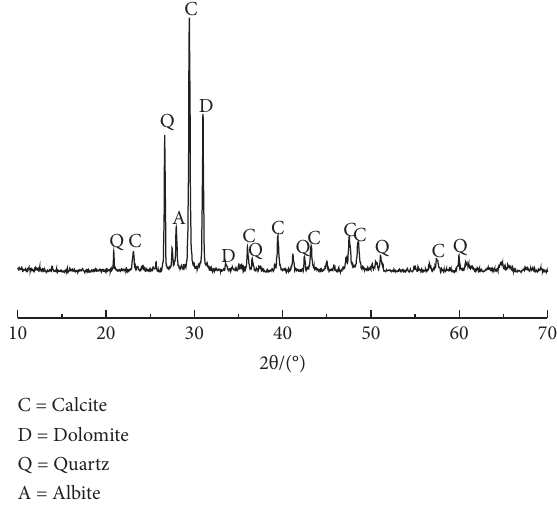
Figure 3: XRD pattern of WCP.